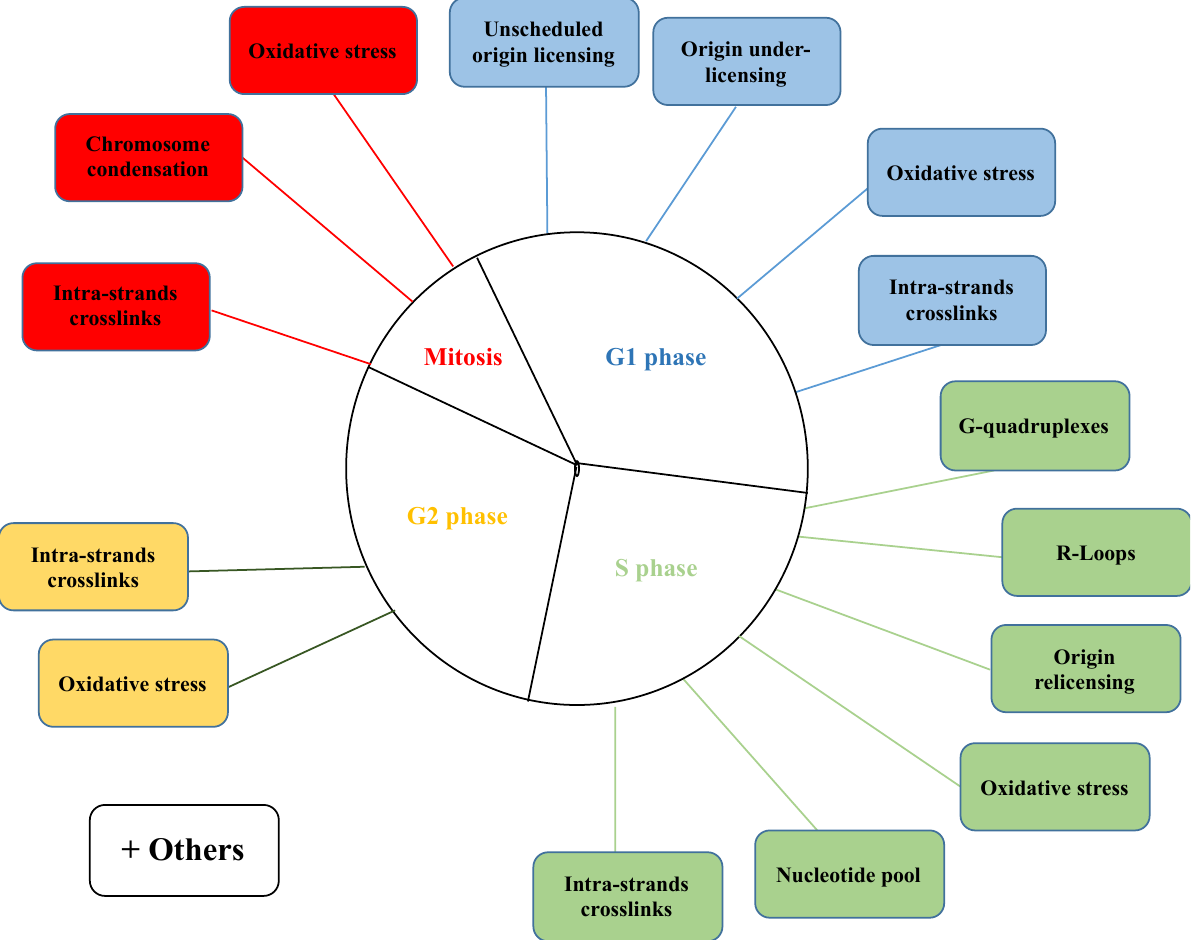
Figure 2. Inducers of replication stress across different phases of the cell cycle. This scheme summa- rizes the possible obstacles during G1 (blue), S (green), G2 (yellow), and mitosis (red) that affect fork progression, thus preventing efficient DNA replication.